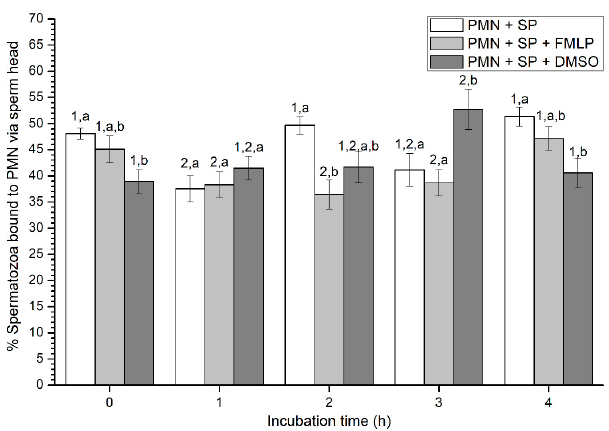
Figure 4. Percentages of viable spermatozoa bound to PMN via sperm head in the three treatments (PMN + SP, PMN + SP + FMLP and PMN + SP + DMSO) throughout the incubation time (4 h; Experiment 2). Different superscripts ( a, b ) mean significant ( p < 0.05) differences between treatments within a given time point, and different numbers ( 1, 2 ) mean significant ( p < 0.05) differences between incubation times within a given treatment. Data are shown as mean ± SEM for seven experiments. Sperm concentration: 500 × 10 6 sperm/mL. PMN concentration: 100 × 10 6 PMN/mL. PMN: polymorphonuclear neutrophils; SP: seminal plasma; DMSO: dimethyl sulfoxide; FMLP: formyl-methionyl-leucyl-phenylalanine.